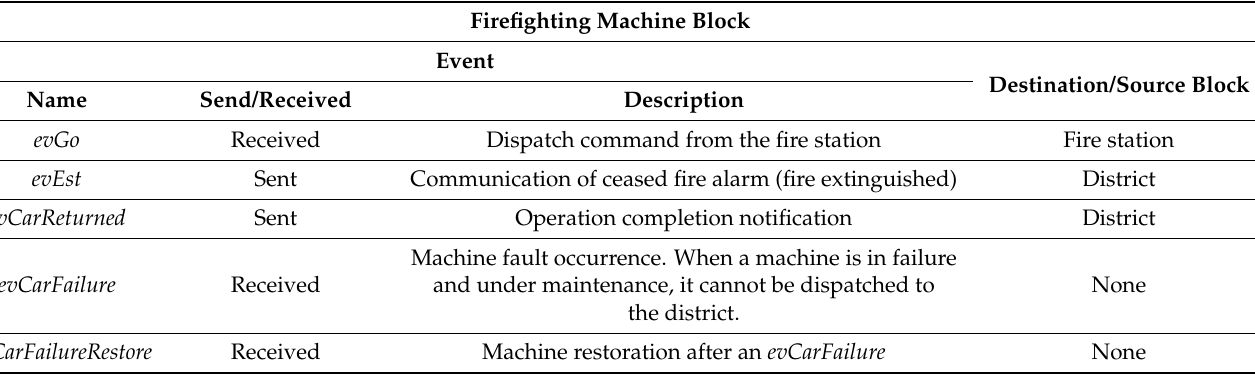
Table 3. Events list of the firefighting machine CS block with event name, direction (send/received), description, and its destination/source